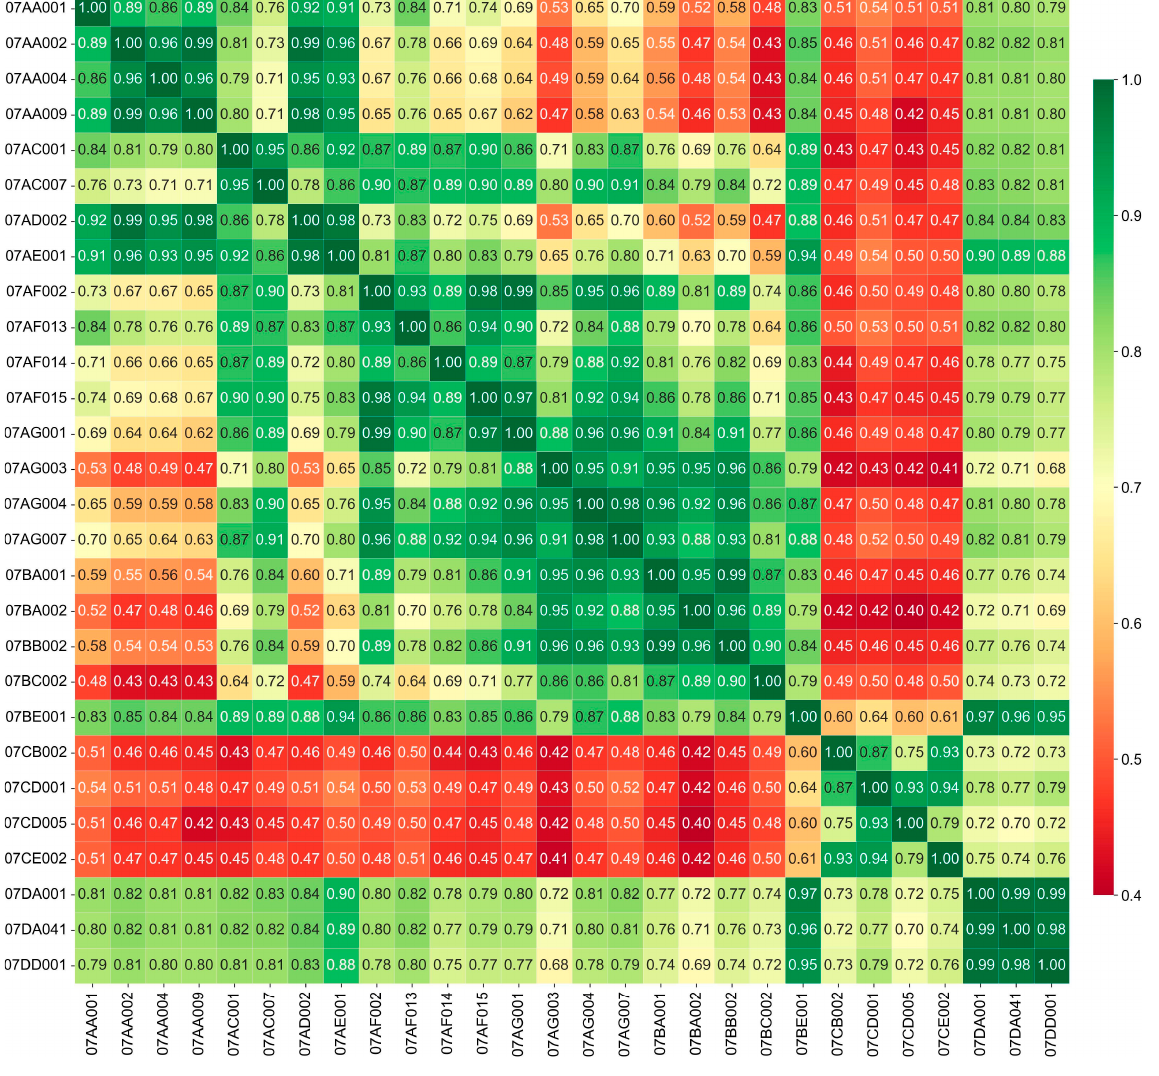
Figure 6. A Pearson correlation table for extended monthly streamflow (m 3 /s) indicates the linear relationship between two variables, presenting the strength and direction of the relationship through a value ranging from − 1 to 1.